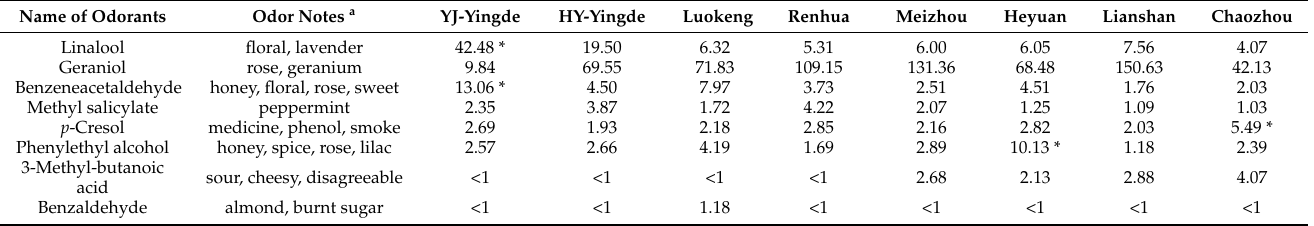
Table 1. OAVs in the eight key VFCs in Guangdong black tea samples.